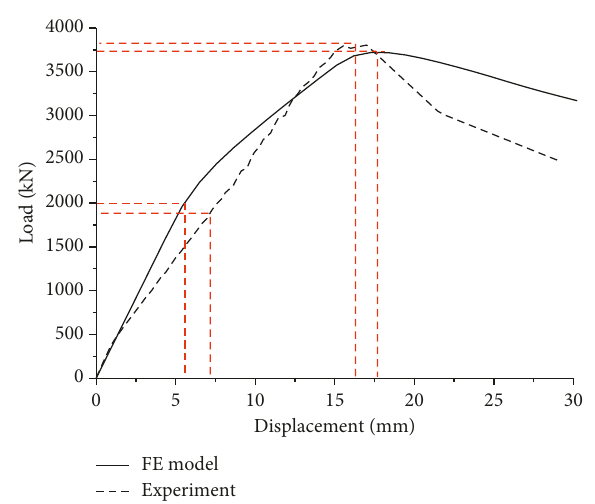
Figure 11: Comparison of experimental and FE modelling